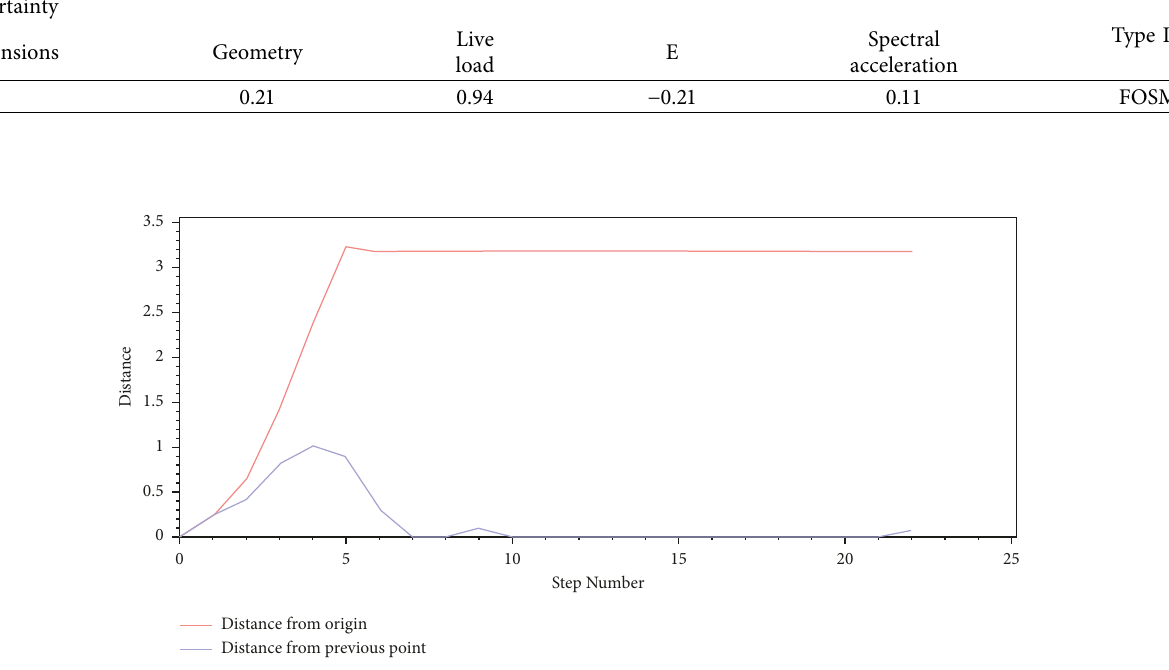
Figure 11: FORM analysis convergence diagram for type III frame in RT program.